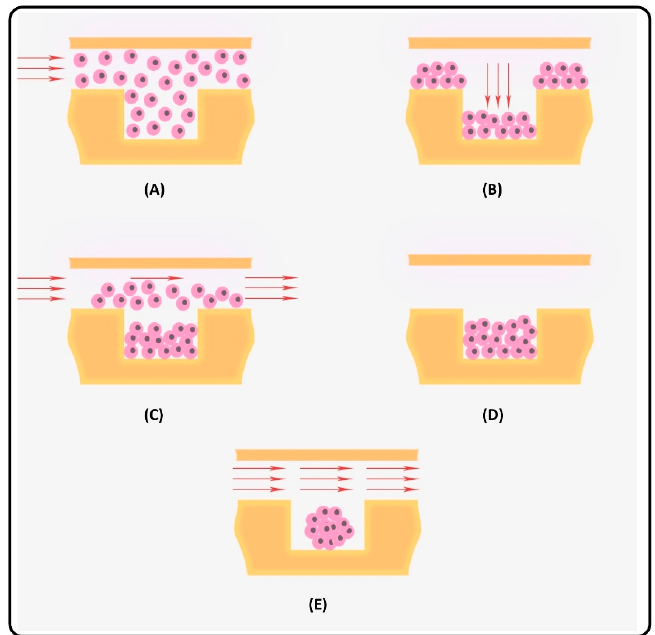
Figure 4. Spheroid formation process in a microwell-based µSFC: ( A ) Introduction of a cell suspension to the chip inlet. The cell suspension fills all the microchannels and microwells rapidly due to the capillary effect; ( B ) Cells start depositing on the bottom of the microchannels and microwells; ( C ) Pure culture medium flows through the chip to rinse the excess cells without disturbing the cells lying on the microwell bottom; ( D ) Cell secretions and signalling lead to establishment of cell-cell interactions on the non-adherent microwell bottom; ( E ) Driving spheroid formation under a perfusing flow of culture medium. Reproduced with permission from [13] Copyright © 2018 Elsevier B.V.